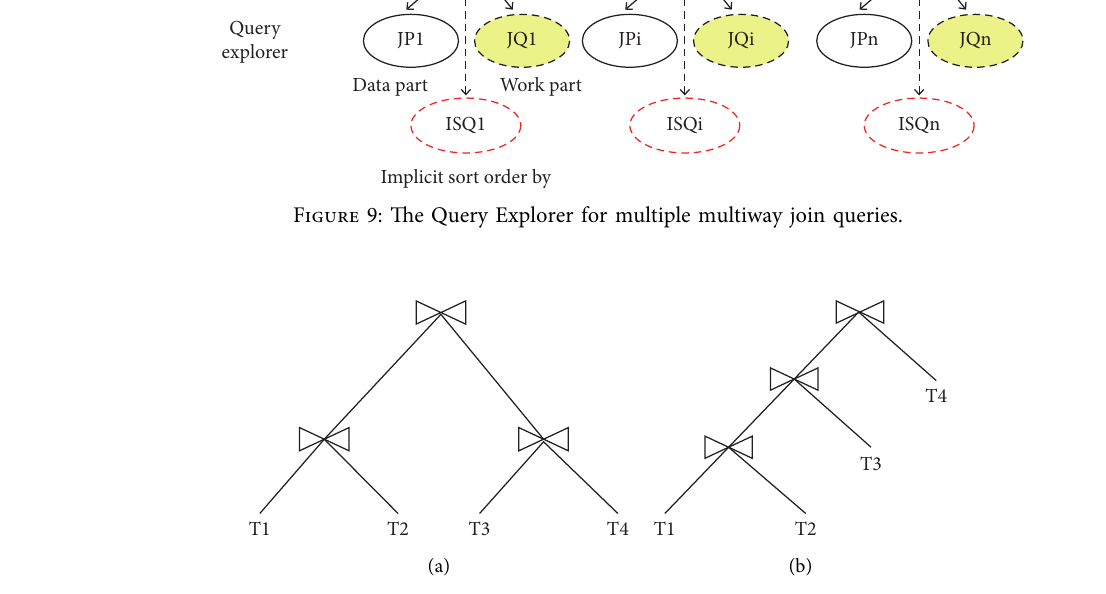
Figure 10: Multiway join execution plan in DBMS. (a) Bushy plan. (b) Left deep